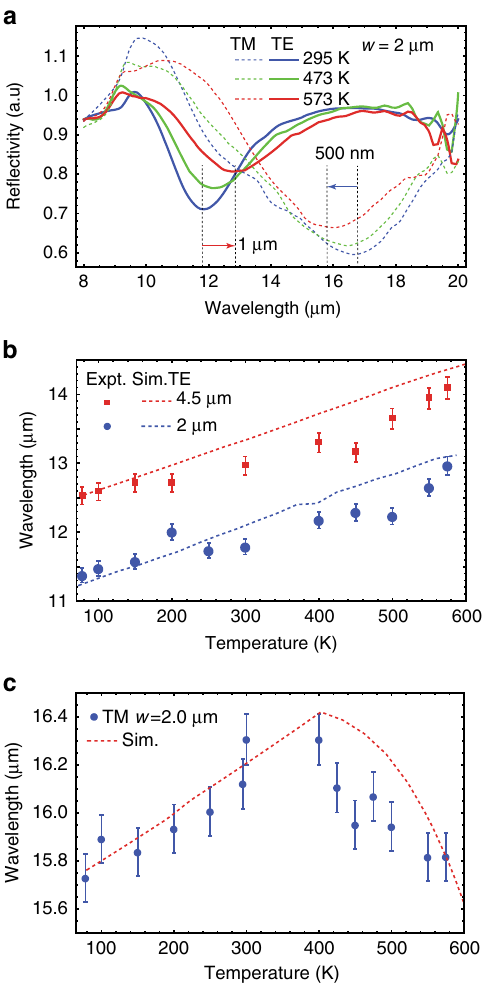
Fig. 4 Thermal dispersion of TE vs TM resonances. a TE ( solid ) and TM ( dashed ) re fl ection spectra of a 2 µ m wide resonator at different temperatures (295 K: blue , 473 K: green and 573 K: red ). The TM resonance red shifts while the TE resonance blue shifts with increasing temperature.